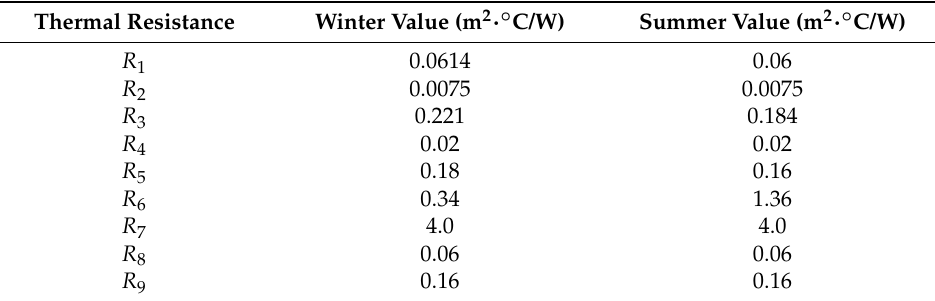
Table 1. Thermal resistance of roof